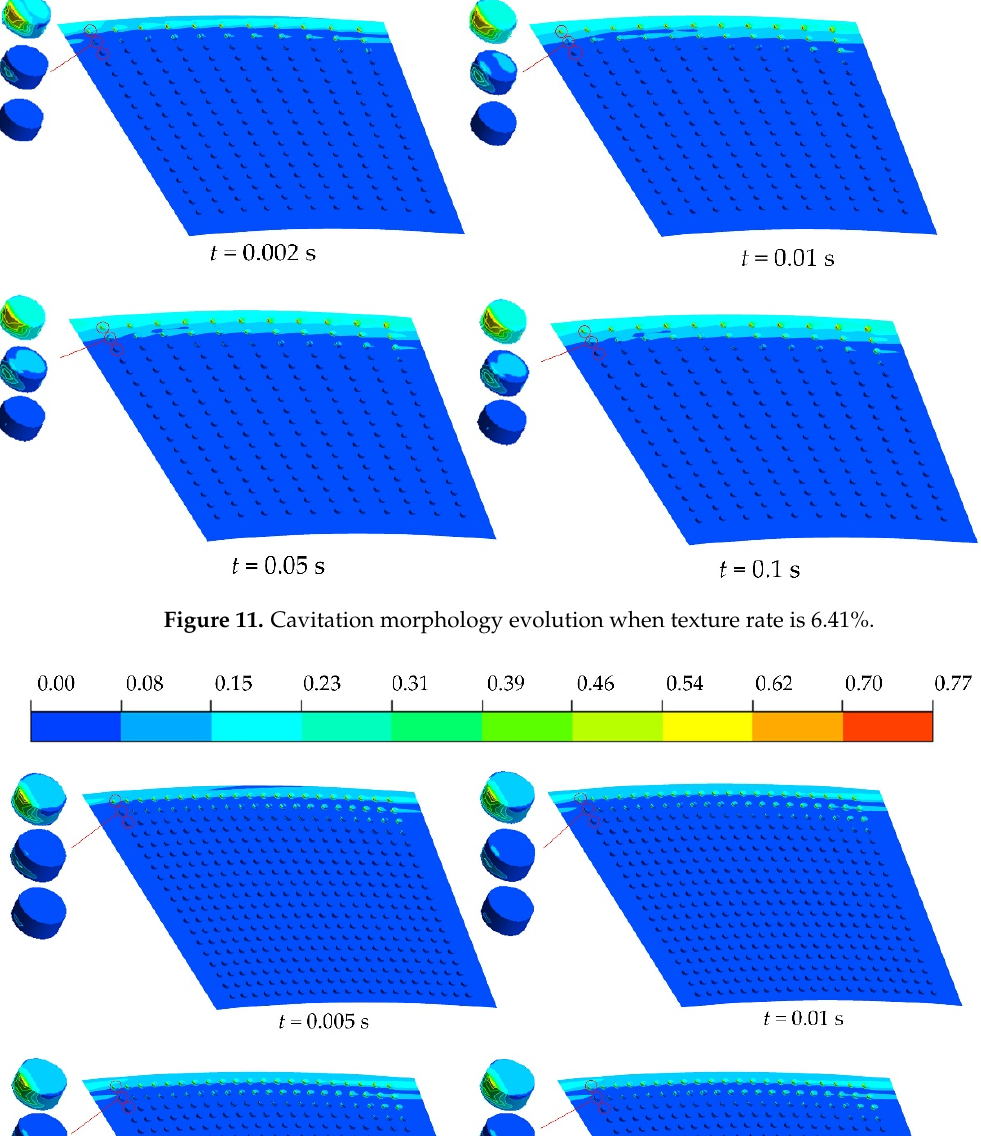
Figure 10. Cavitation morphology evolution when texture rate is 3.205%.